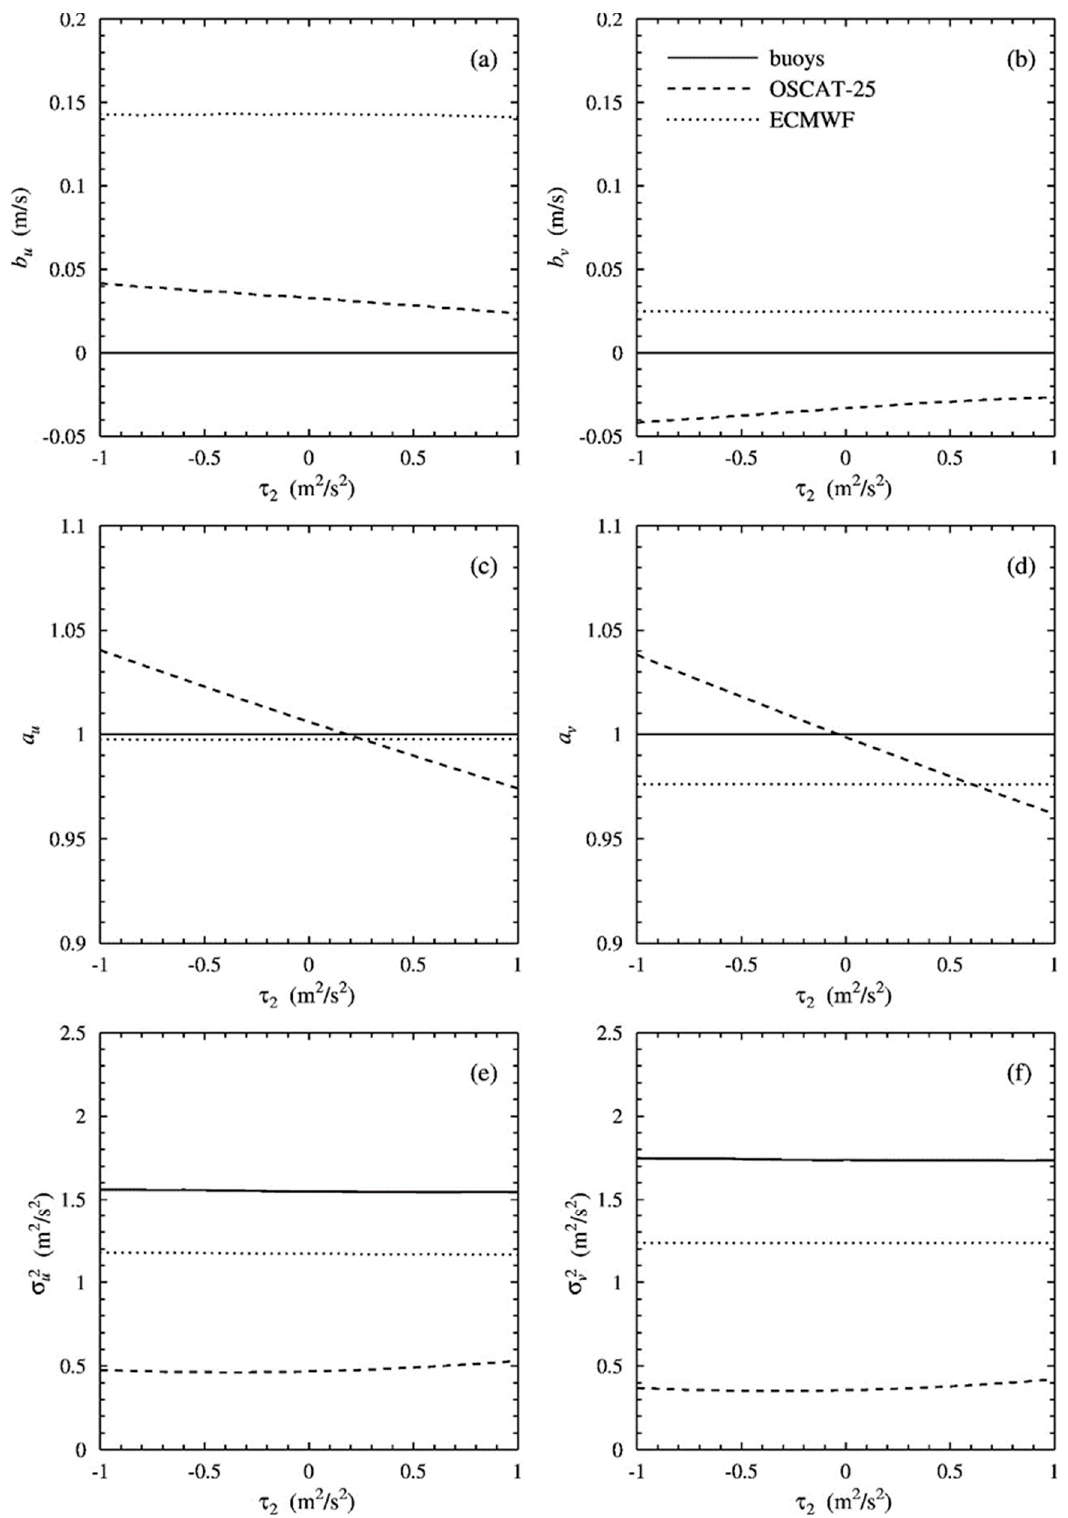
Figure 2. As Figure 1, but for error non-orthogonality τ _2 in OSCAT (system 2).